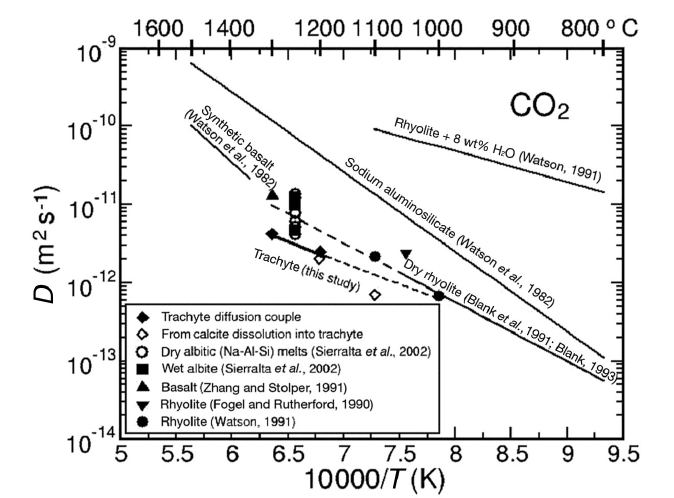
Fig. 2. Diffusion of carbon dioxide in magmatic silicate melts. Note that the variation of measurements in the work of Sierralta et al . (2002) is due to the variety of compositions used in their experiments, see text for fur- ther